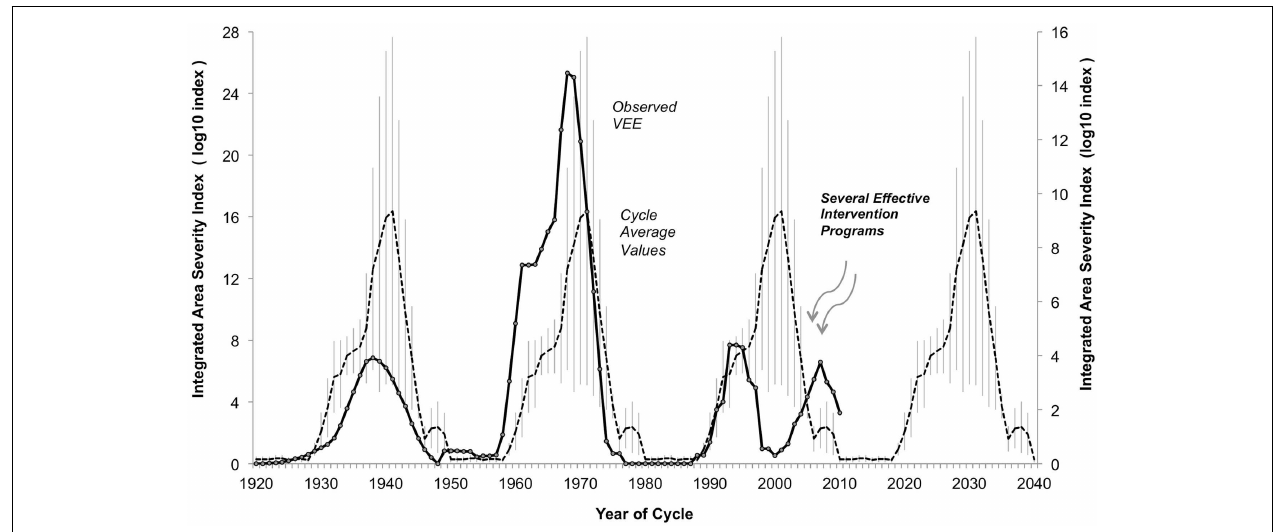
OutbreakTwo (1950–1979) and OutbreakThree (1980–2009) ( dashed line , right axis, log10 scale), with standard error of mean added ( light vertical lines ). Outbreak One (1920–1949) values excluded from average due to lack of solid data. Subdued levels ofVEE over OutbreakThree could be the result of assertive mosquito control programs related to dengue fever epidemics, and/or improvedVEE management approaches and infrastructure (see text for